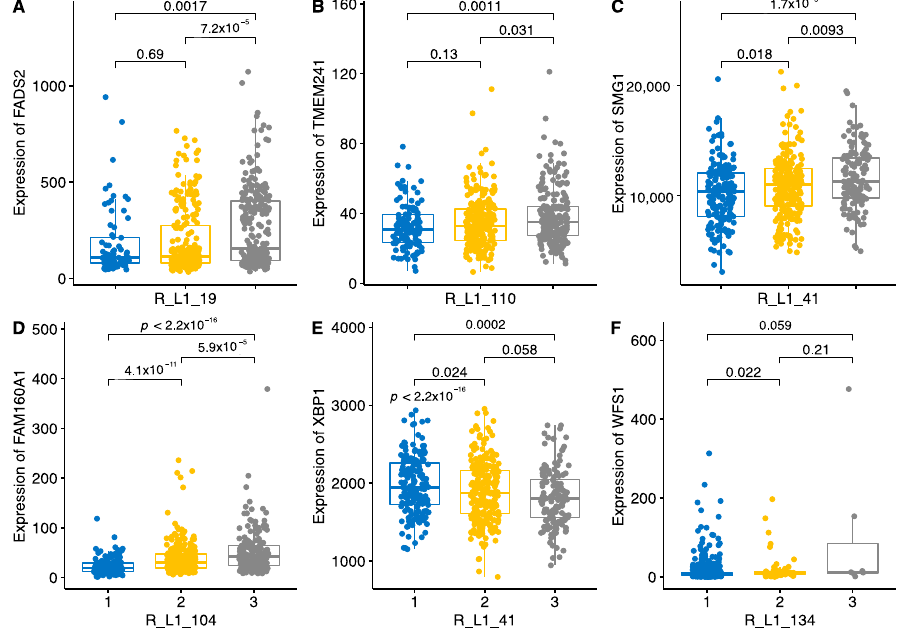
Figure 8. Boxplot of six different genes influenced by L1s. Genotypes of L1s are shown as number 1 for AA, 2 for PA and 3 for PP. Numbers and lines above the bar show p -values of the pairwise comparison. p -values are from the Wilcoxon pairwise comparison. Panels A-F show different regulatory effects of variable L1s. E panel shows dose-dependent downregulating effect.